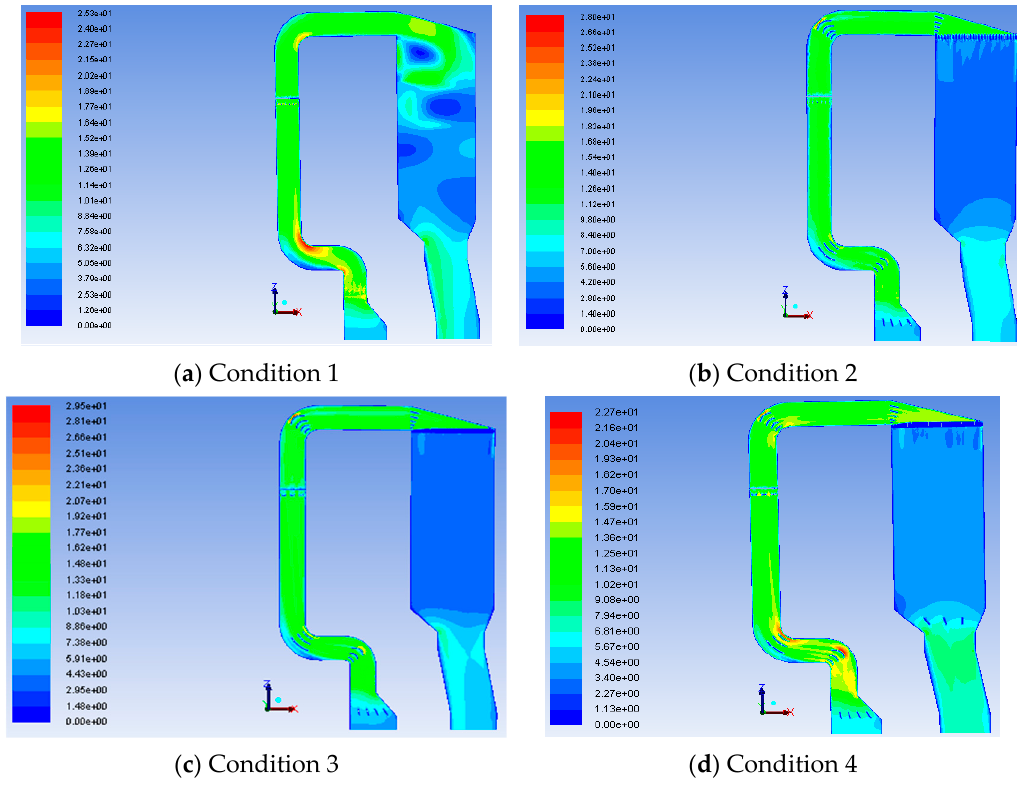
Figure 4. Velocity profile of the SCR reactor under various conditions. ( a ) Condition 1; ( b ) Condition 2; ( c ) Condition 3; ( d ) Condition 4.